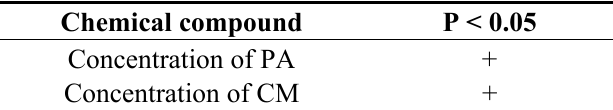
Table 2. Significance analysis of the influence of the chemical compound concentration on the porosity of the manufactured sinters (ANOVA).